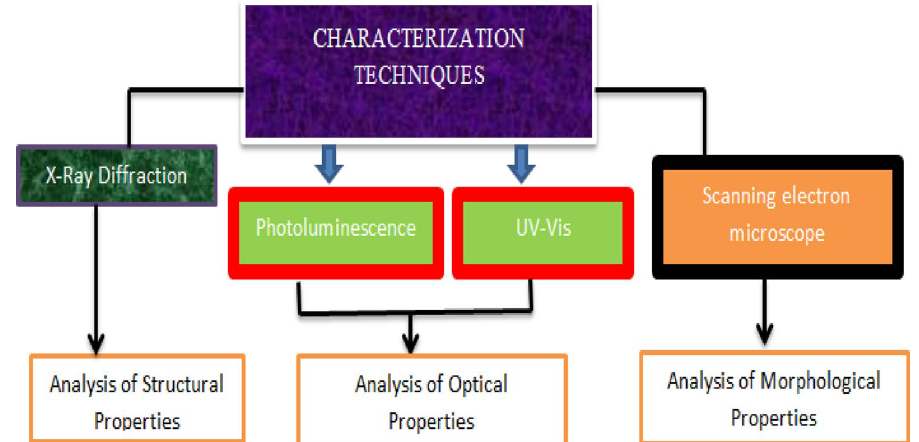
Figure 3. Characterization techniques and its uses.